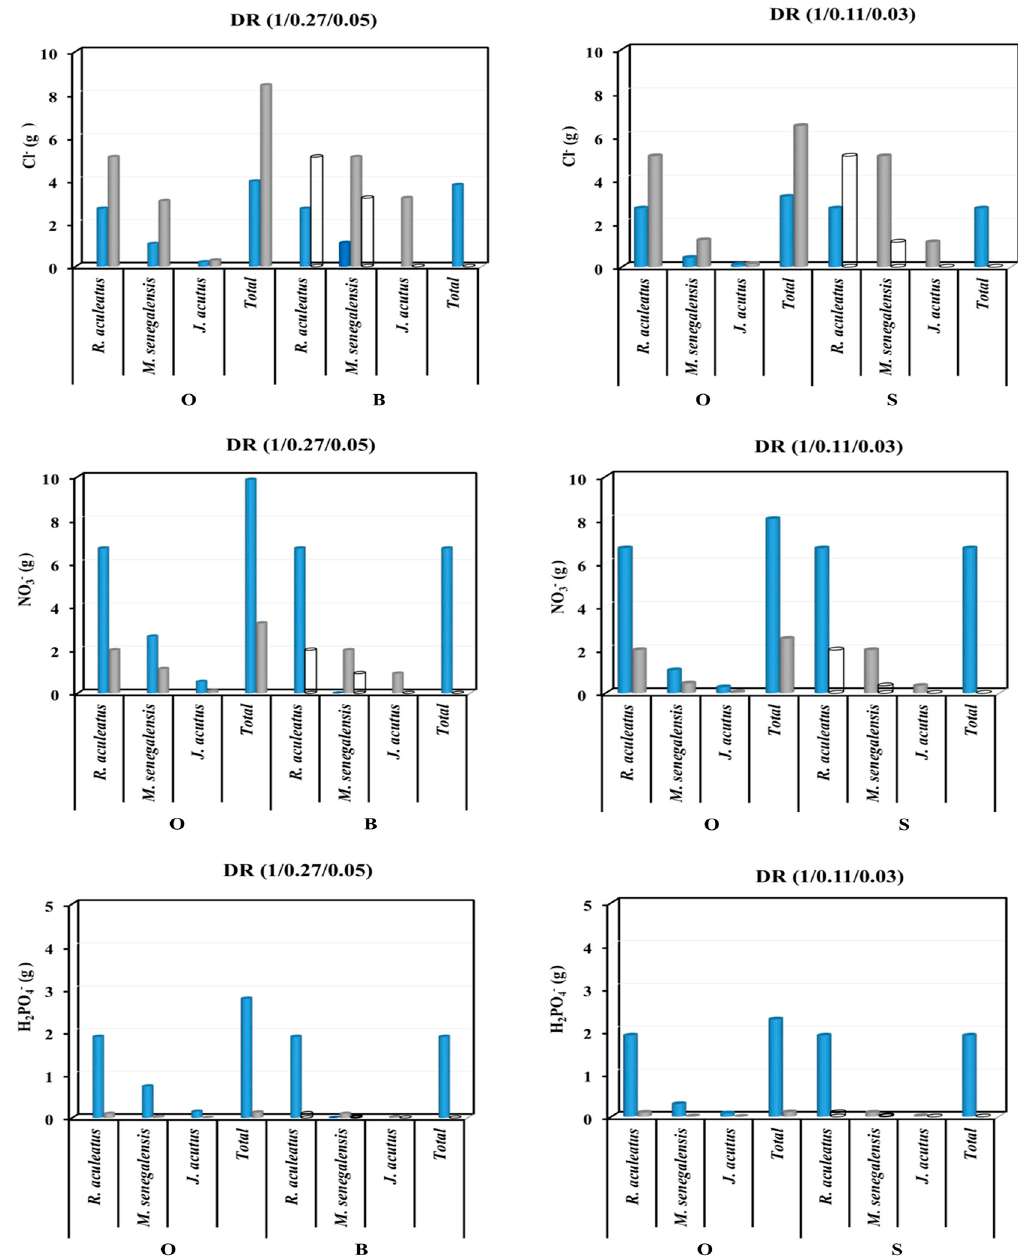
Figure 2. Water volume and anion loads of each water treatment for their respective distribution ratio itemized by species and the total (DR, distribution of the number of plants of the three species that can be grown in each water system). O—open system, B—blended water system, and S—sequential reuse water system.